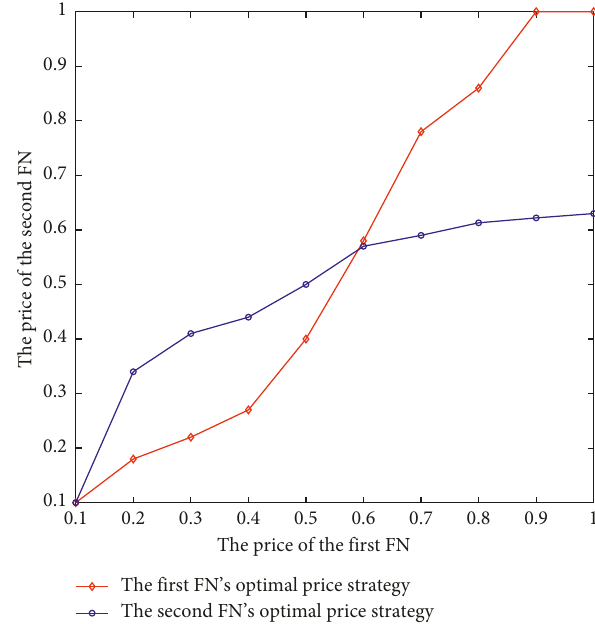
Figure 4: Relationship between the service radius and vehicle density.